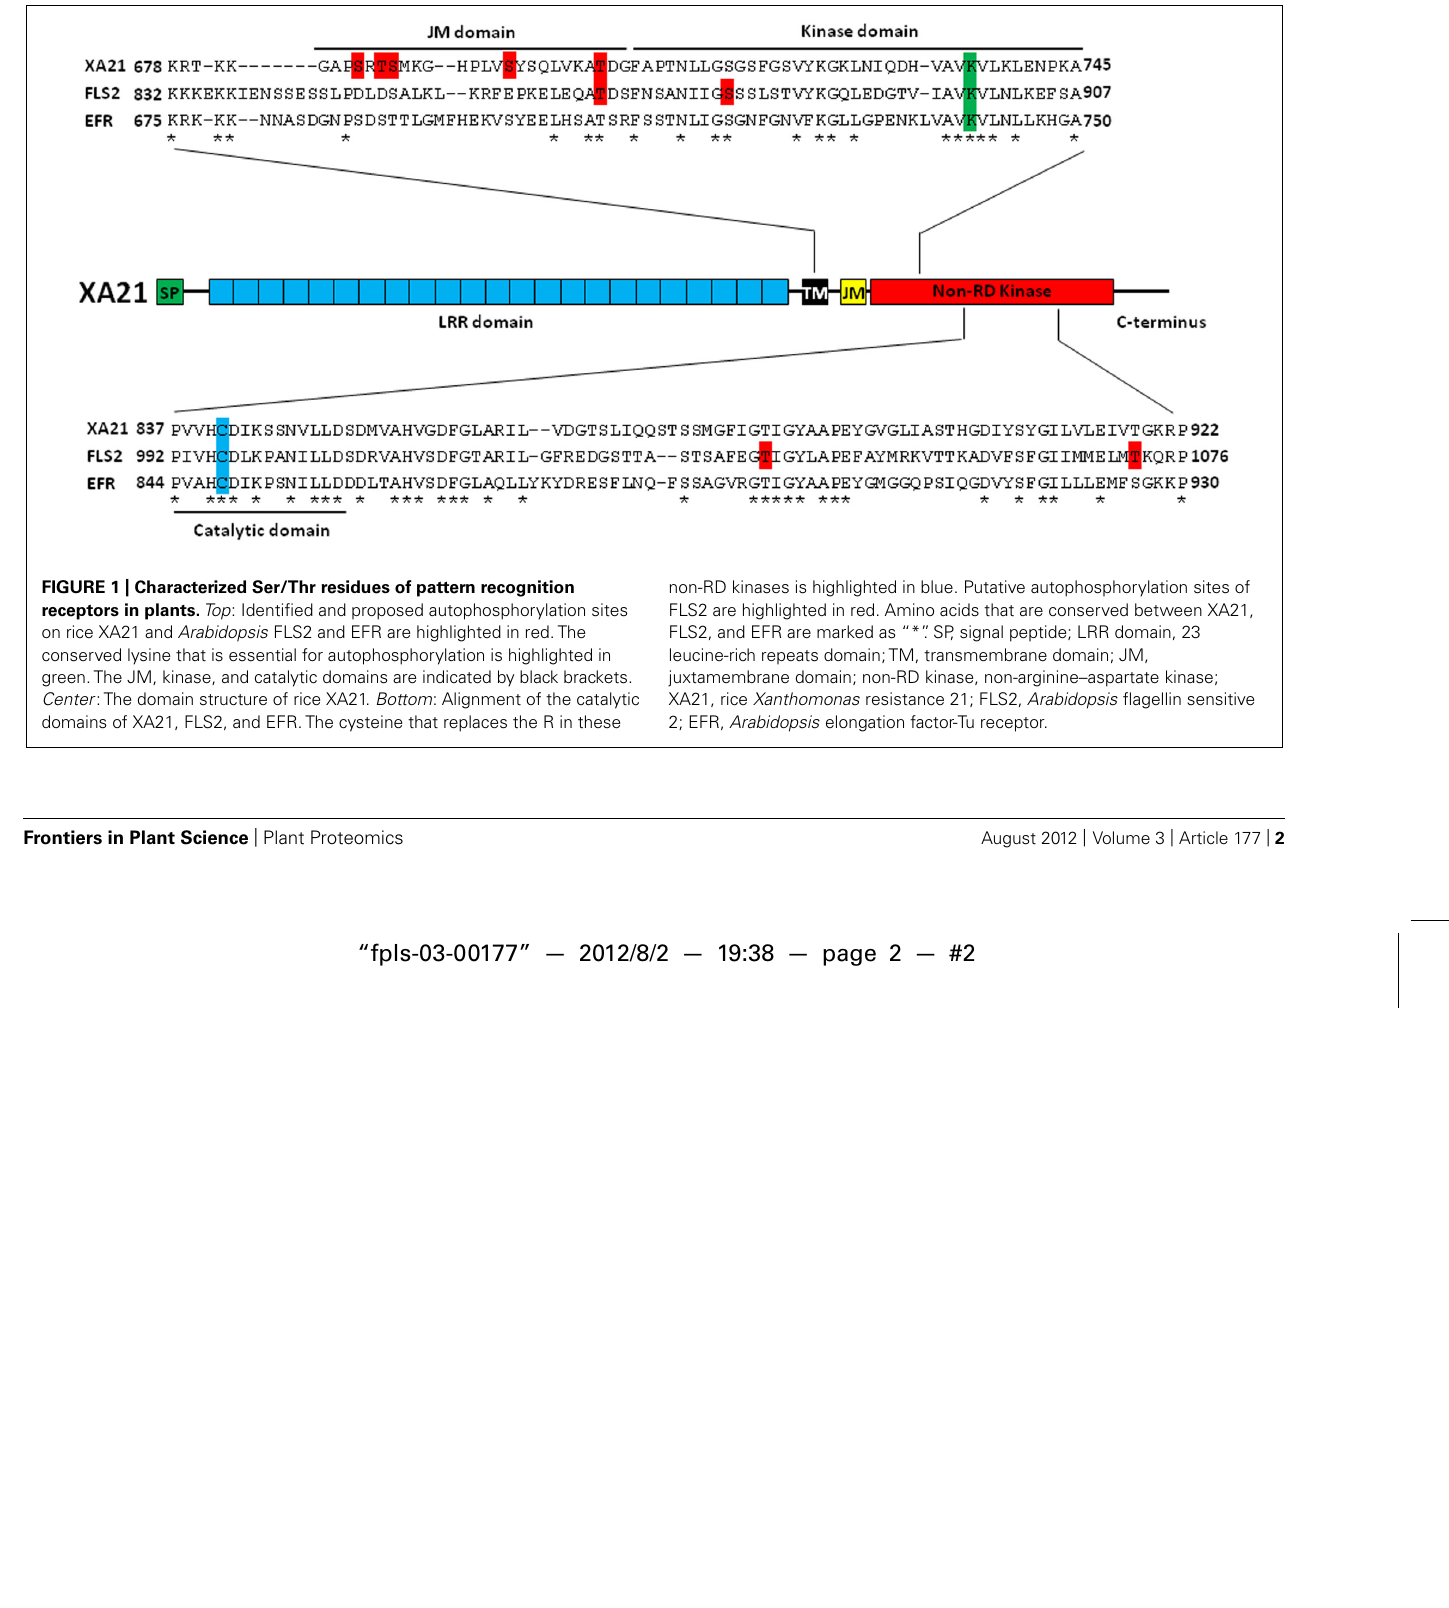
non-RD kinases is highlighted in blue. Putative autophosphorylation sites of FLS2 are highlighted in red. Amino acids that are conserved between XA21, FLS2, and EFR are marked as “*”. SP, signal peptide; LRR domain, 23 leucine-rich repeats domain;TM, transmembrane domain; JM, juxtamembrane domain; non-RD kinase, non-arginine–aspartate kinase; XA21, rice Xanthomonas resistance 21; FLS2, Arabidopsis flagellin sensitive 2; EFR, Arabidopsis elongation factor-Tu